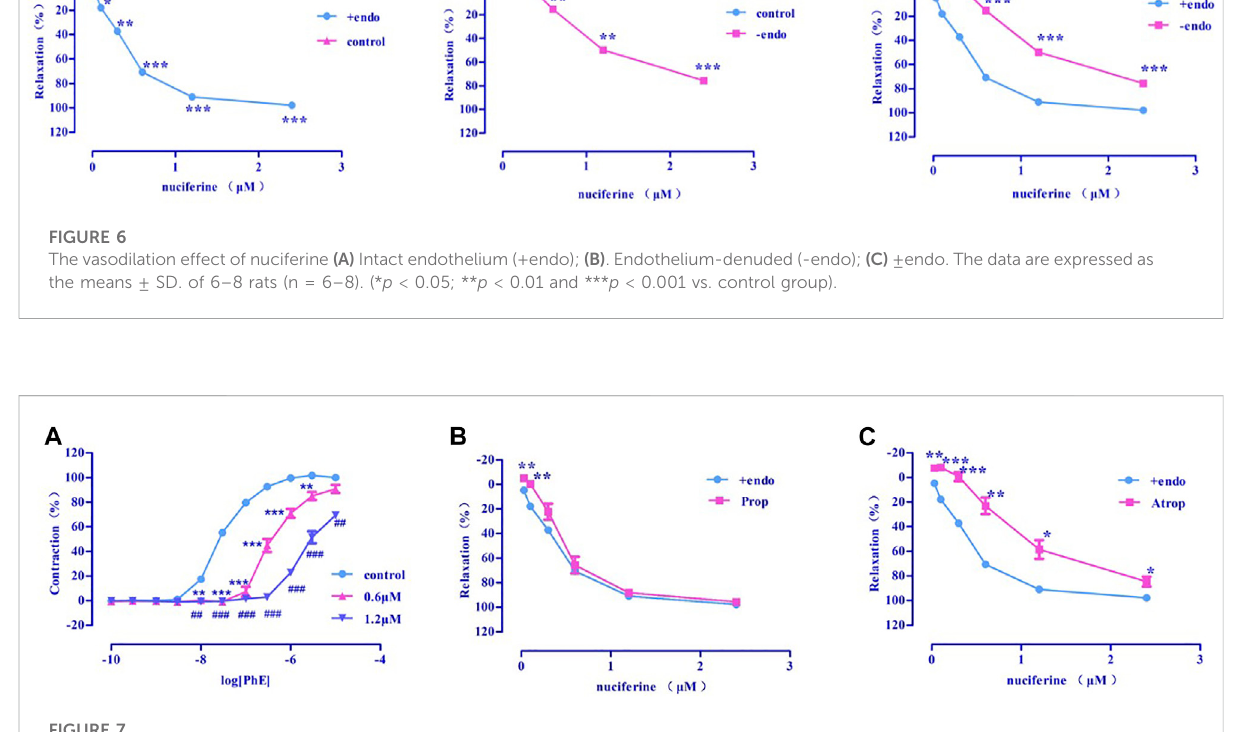
FIGURE 7 (A) α -receptor. (B) β receptor. (C) M receptor. The data are expressed as the means ± SD of 6 – 8 rats ( n = 6 – 8). (* p < 0.05, ** p < 0.01 and *** p < 0.001 vs. control group; # p < 0.05, ## p < 0.01 and ### p < 0.001 vs. control